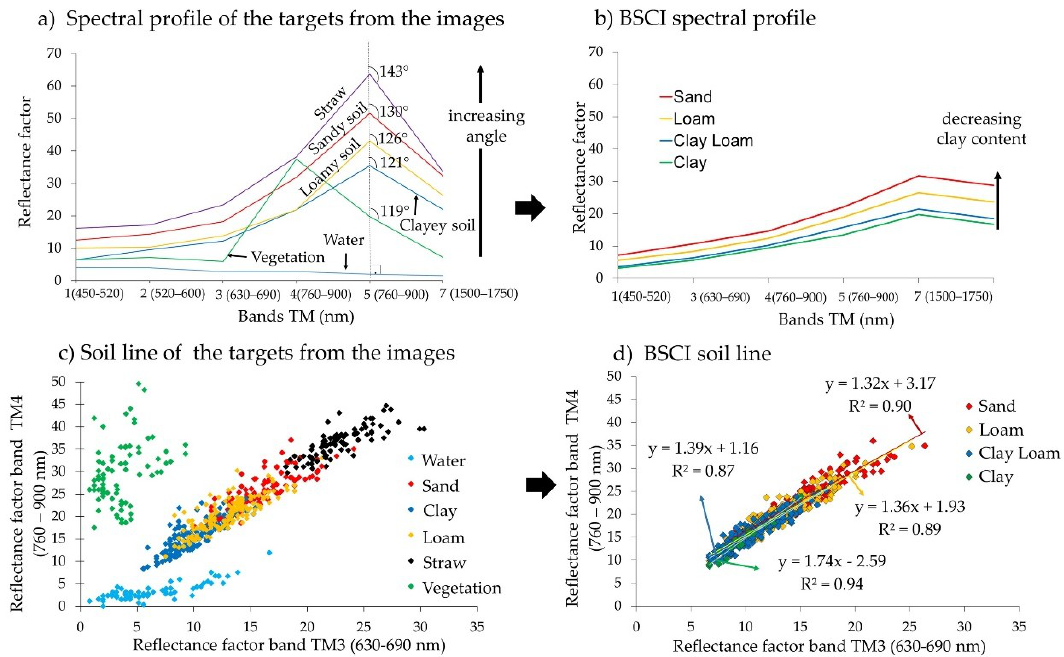
Figure 8. ( a ) Standard spectral profile of targets from the satellite images and the angles with TM5; ( b ) BSCI spectral profile, ( c ) Soil line of different targets from the satellite images and ( d ) BSCI soil line. The soil line plot from bands TM3 and TM4 (red and NIR wavelengths) (Figure 8c) is